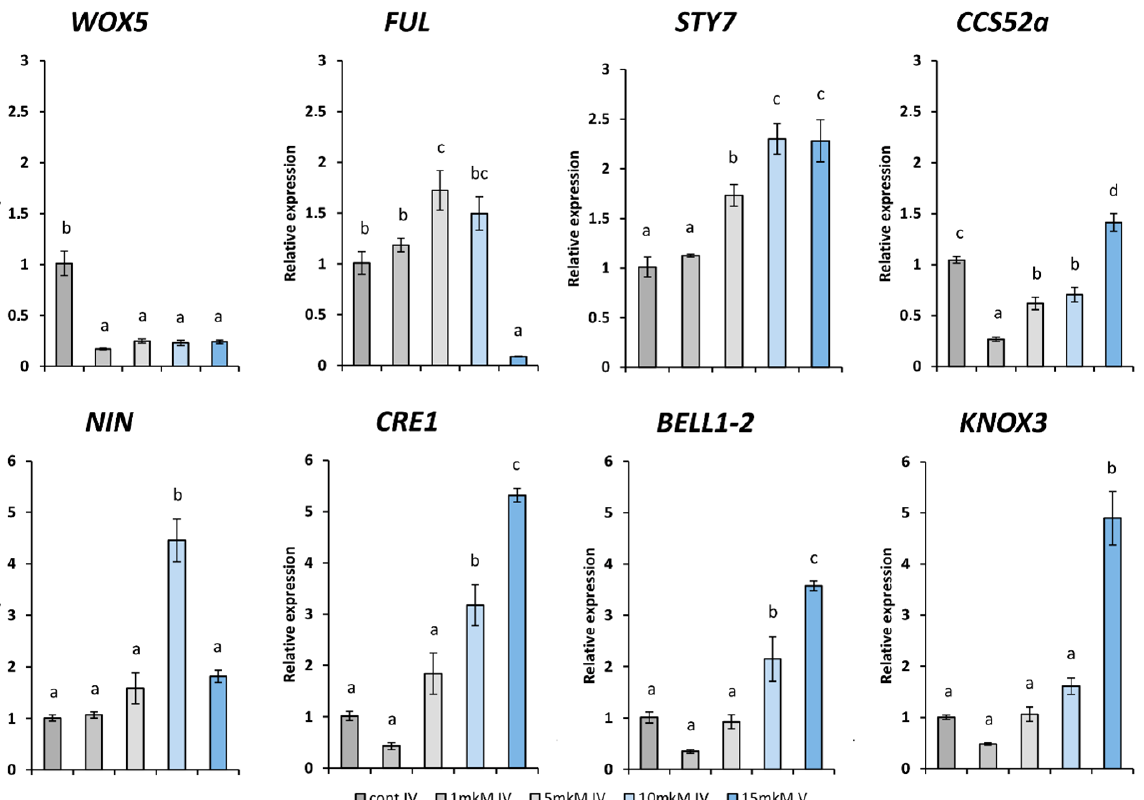
Figure 5. Expression patterns of WOX5 , NIN , CCS52a , CRE1 , BELL1-2, and KNOX3 genes involved in regulation of nodule development as well as newly identified genes encoding STY7 and AGL (FUL) transcription regulators in nodules of sym33-3 mutant plants non-treated (control) or treated with increasing concentrations of cytokinin 6- BAP: 1 μM, 5 μM, 10 μM, and 15 μM (14 days after inoculation, 14 dai). As a control, the nodules of non-treated sym33-3 plants were used. The expression was normalized against the constitutively expressed ubiquitin gene. For each gene, the transcript level in nodules of non-treated mutant plants was set to 1 (control), and the level in nodules of cytokinin-treated mutant plants was calculated relative to the control values. Analysis of changes in gene expression was carried out on the basis of three biological repeats. The results of one representative biological repeat were shown out of three, and the standard error of the mean (SEM) of three technical replicates. The different letters indicate statistically significant differences based on one-way analysis of variance (one- way ANOVA), followed by Tukey’s post -hoc test results.